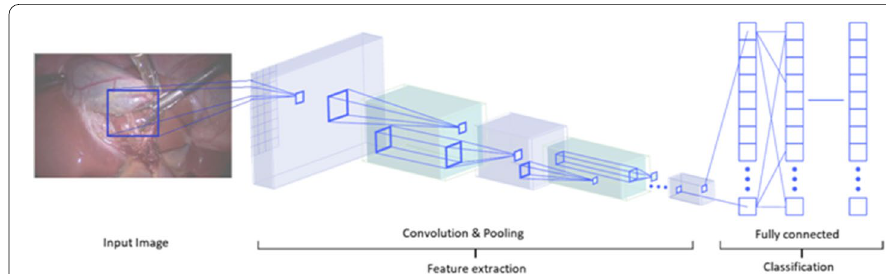
Fig. 3 Convolutional Neural Network architecture